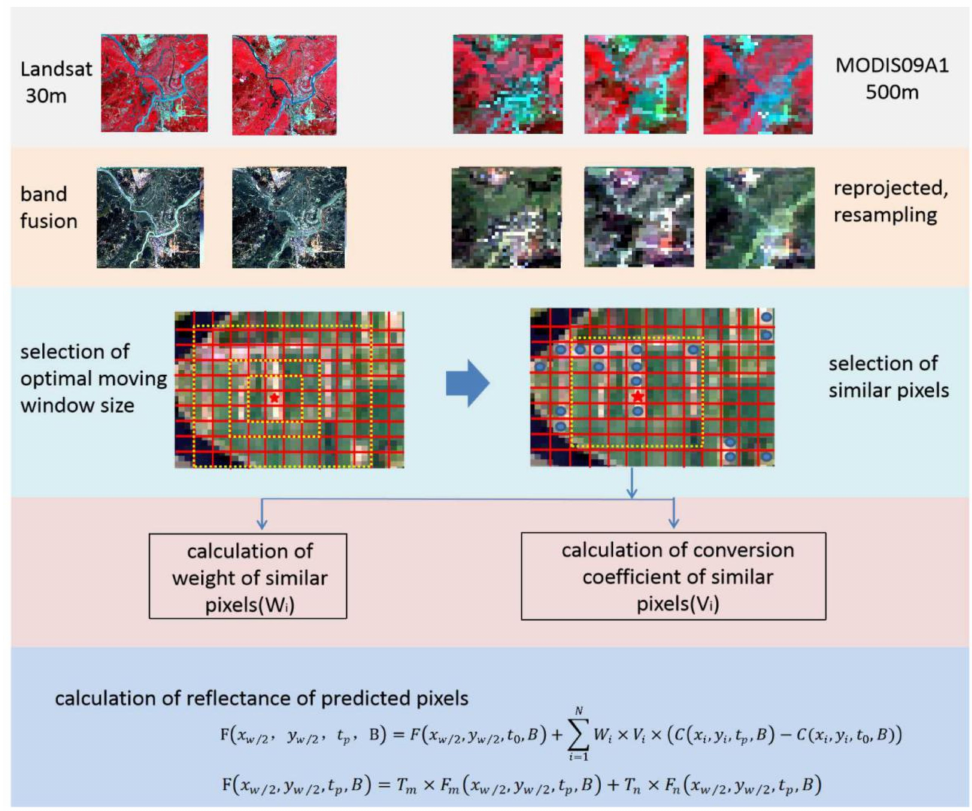
Figure 3. The algorithm flow of an adaptive moving window strategy in the spatiotemporal data fusion